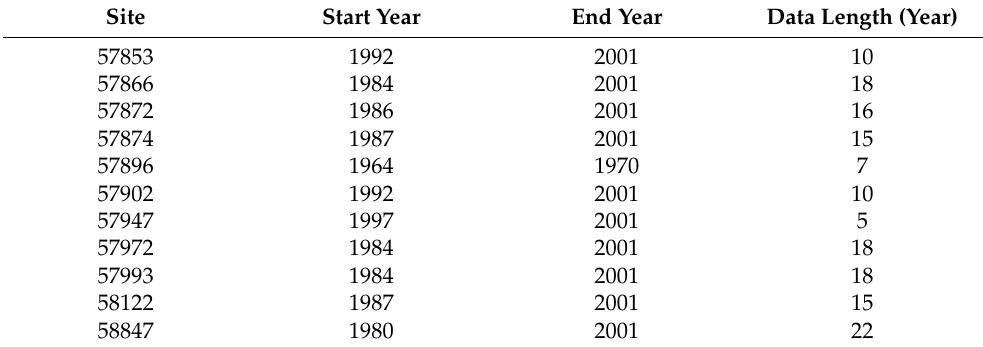
Table 2. Representative correlation matrix of evaporation data for sites.